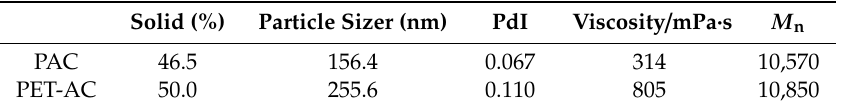
Figure 9. TEM micrograph of the PAC and PET-AC latex particles. According to Table 3, the solid content of emulsion after polyester modification was slightly higher than the pure PAC. From Figure 8, the PET/AC emulsion had a larger average particle size and wider distribution than PAC emulsion. As can be seen from Figure 9, the particle size of PET-AC